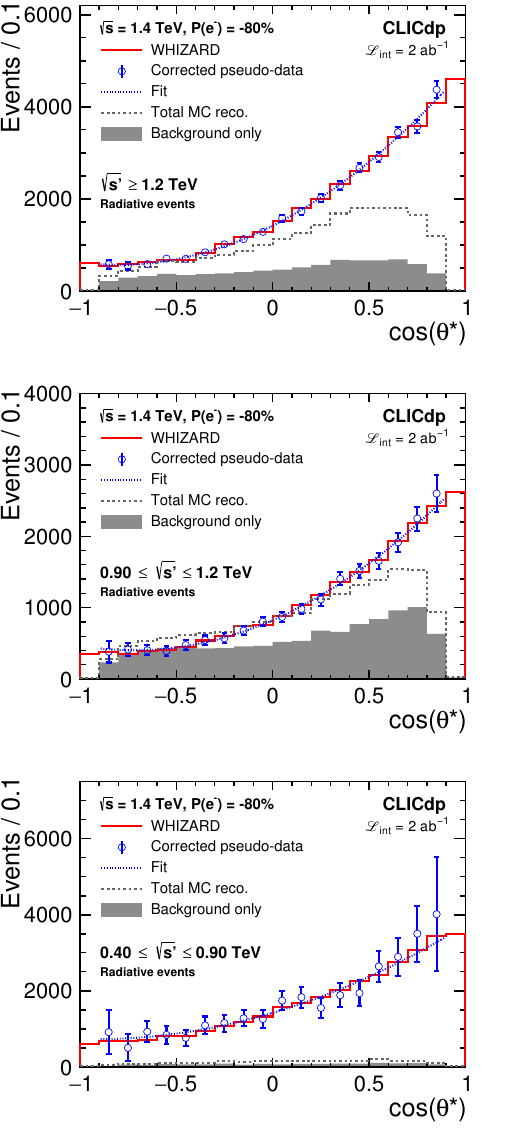
Figure 19. The top-quark polar angle distributions for the analysis of radiative semi-leptonic tt p events at s = 1 : 4 TeV, for P (e (cid:0) ) = -80% (left column) and P (e (cid:0) ) = +80% (right column), and an integrated luminosity of 2 : 0 ab (cid:0) 1 and 0 : 5 ab (cid:0) 1 , respectively. Distributions are shown for the p three signal regions in s 0 . The dashed black curve shows the reconstructed total MC distribution, while the grey area indicates the level of background only. The blue data points and dotted line represent one pseudo-experiment after subtraction of background and correction for (cid:12)nite selection e(cid:14)ciencies, and the corresponding (cid:12)t, respectively. The red solid line represents the simulated parton-level